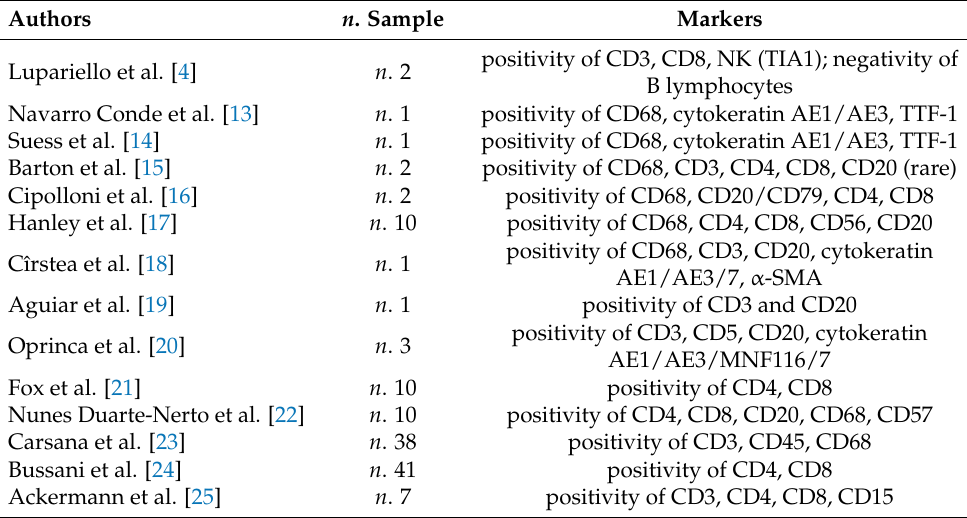
Table 1. Summary of immunohistochemical markers for lung inflammatory